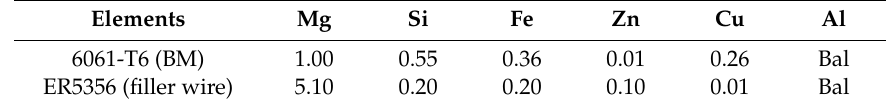
Table 1. Chemical compositions (wt%) of base metal and filler wire.